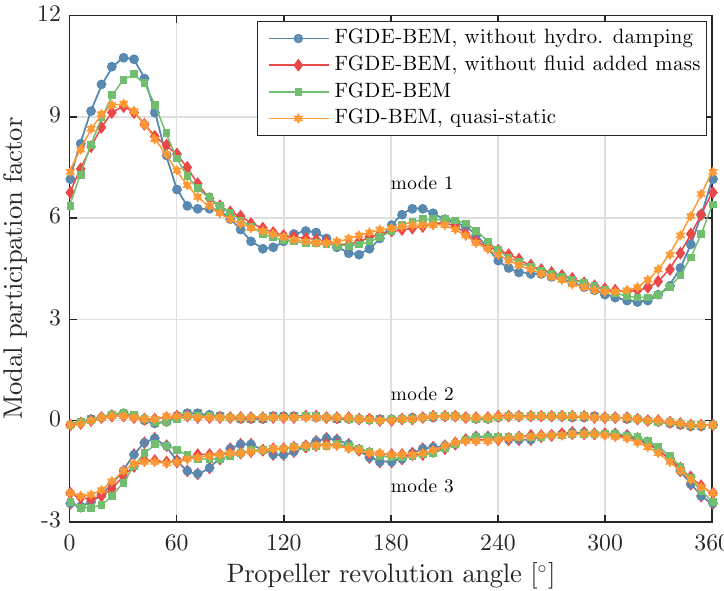
Figure 19. Modal participation for first three modes computed with the FGDE-BEM-FEM coupling with and without including the fluid added mass and hydrodynamic damping in the calculations, for the glass–epoxy Seiun–Maru propeller.